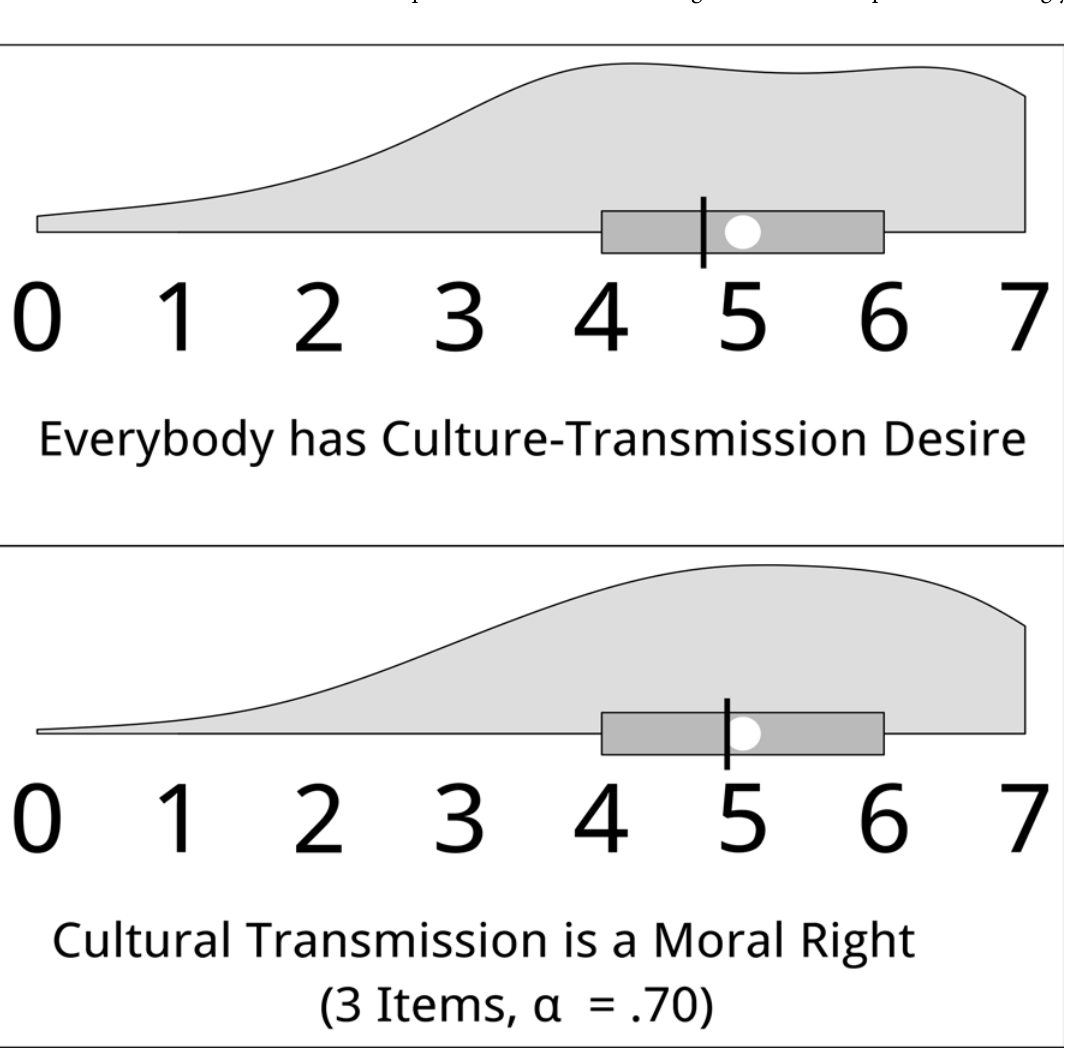
Fig 5. Distribution of the belief in the existence of the culture-transmission motive in others, and the perceived right of migrants to maintain their culture. Answers were given on scales ranging from 0 = “ do not agree at all ” to 7 = “ agree completely ” . The white circle represents the median and the black bar the mean; the box ranges from the first to the third